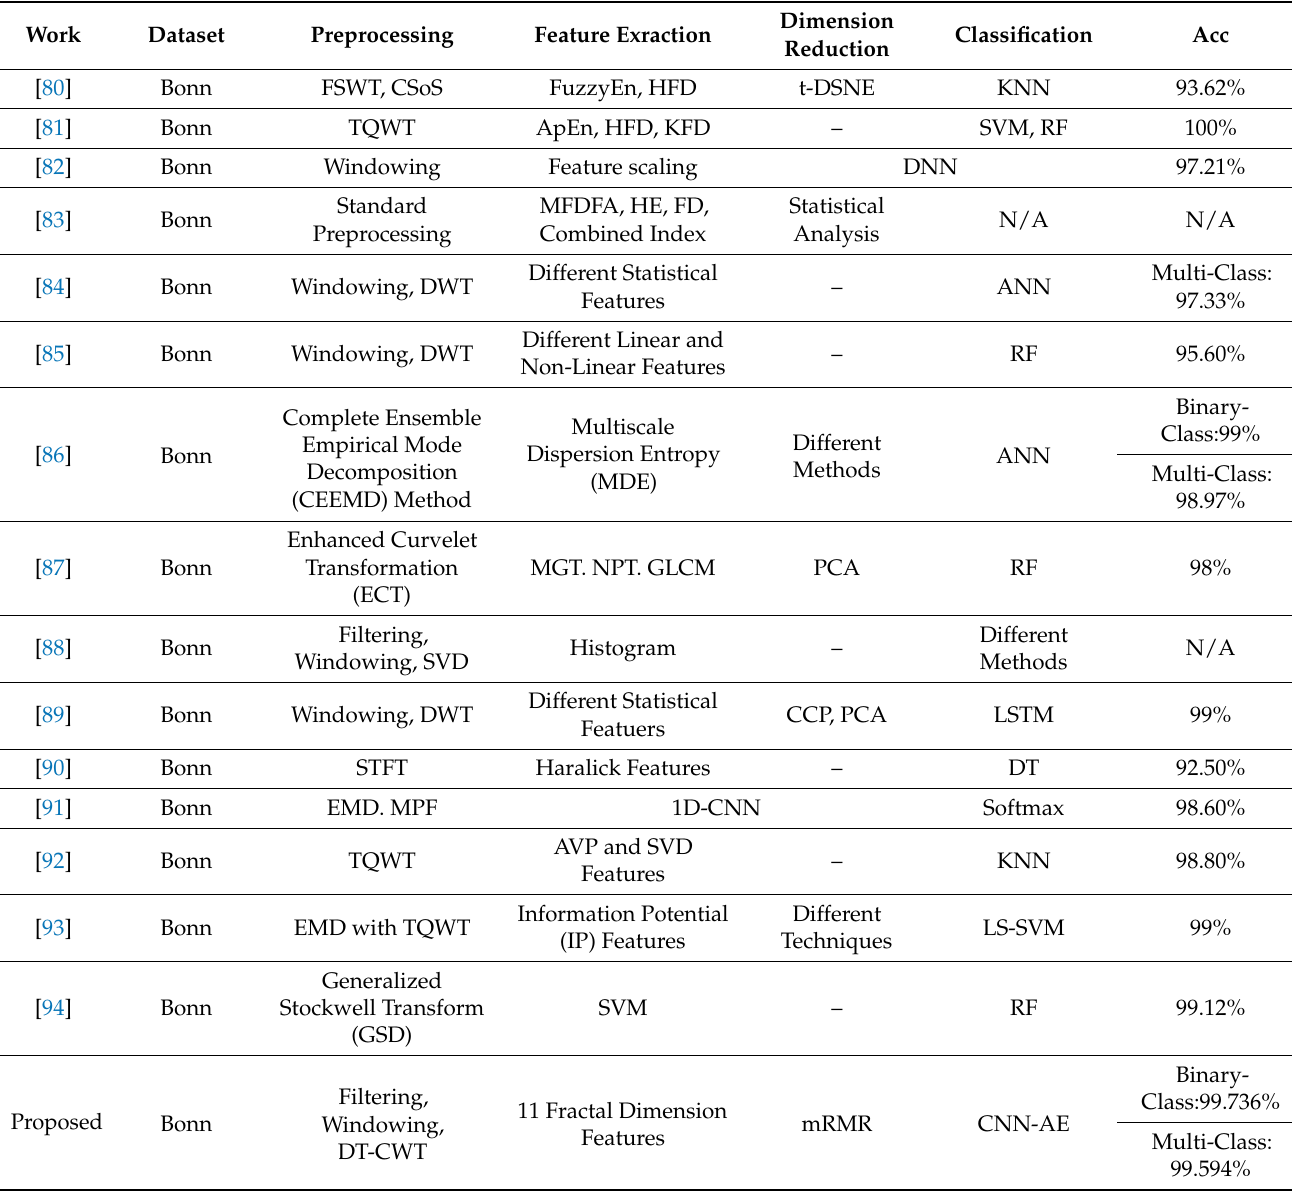
Table 10. Comparison of proposed method with other related works on the Bonn